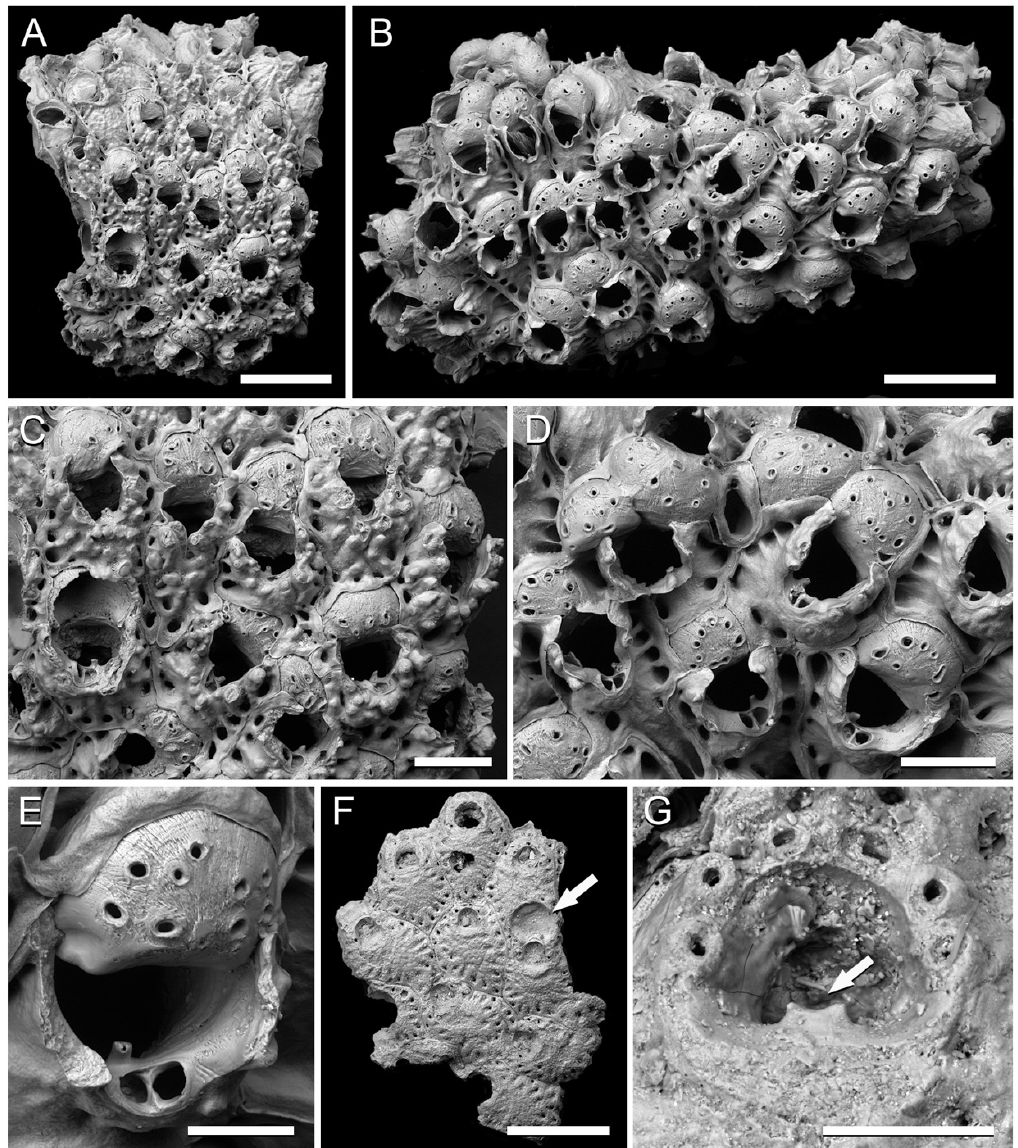
Figure 5. Cheilostome bryozoans from the Clyde Clay Formation of Garvel Park, Greenock, Scotland. ( A – E ) Rhamphostomella radiatula (Hincks, 1877); ( A,C ) NHMUK B1223f; ( A ) colony fragment with growing edge at top; ( C) zooids; ( B,D,E ) NHMUK B1223g; ( B ) colony fragment; ( D ) group of ovicellate zooids; ( E ) ovicell, tooth-like lyrula and suboral avicularium. ( F,G ) Escharella immersa (Fleming, 1828); ( F ) fragment of a colony with broken ovicell (arrowed), NHMUK B1223m; ( G ) orifice with oral spine bases and lyrula (arrowed), NHMUK D1703. Scale bars: A, B, F = 500 µm; C, D = 200 µm; E, G = 100 µm.